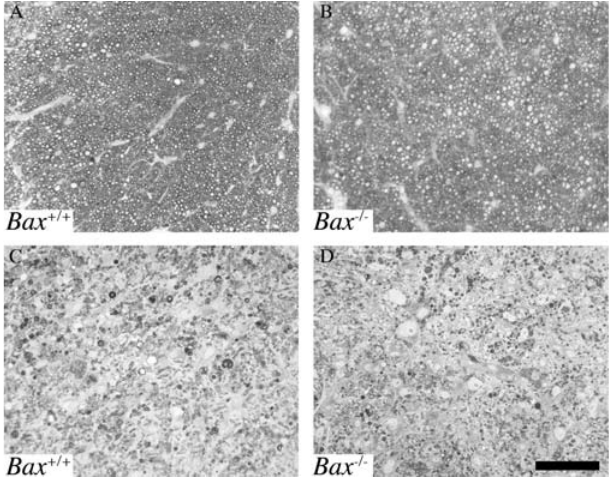
Figure 2. BAX Is Not Required for Glaucomatous Optic Nerve Degeneration To assess the effects of Bax deficiency on optic nerve degeneration, we analyzed PPD-stained optic nerve cross sections from Bax +/+ and Bax (cid:1) / (cid:1) mice ( n . 49 for each genotype; see Materials and Methods). (A and B) Before the DBA/2J glaucoma damages RGCs, the optic nerves of both Bax +/+ (A) and Bax (cid:1) / (cid:1) mice (B) had a normal organization. The axons appeared healthy with a clear axoplasm and darkly stained myelin sheath. (C and D) BAX deficiency did not prevent glaucomatous optic nerve damage. Severe degeneration involving extensive to complete axon loss and scarring occurred in both Bax +/+ (C) and Bax (cid:1) / (cid:1) mice (D). The majority of mice of both genotypes had this severe degree of damage by 12 mo of age. These experiments show that BAX is not required for glaucomatous axon degeneration. Scale bar, 50 l m. DOI: 10.1371/journal.pgen.0010004.g002